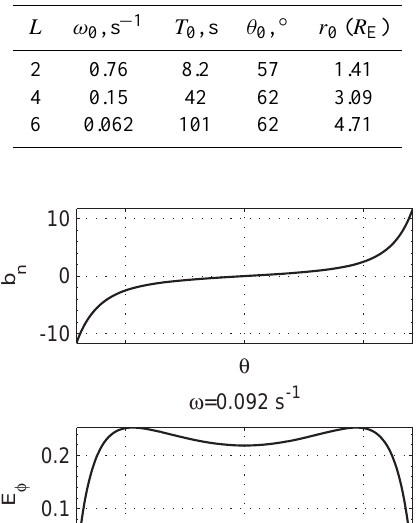
Table 4. List of parameters for L = 2 , 4 , 6 of a dipole field for poloidal standing Alfvén waves.